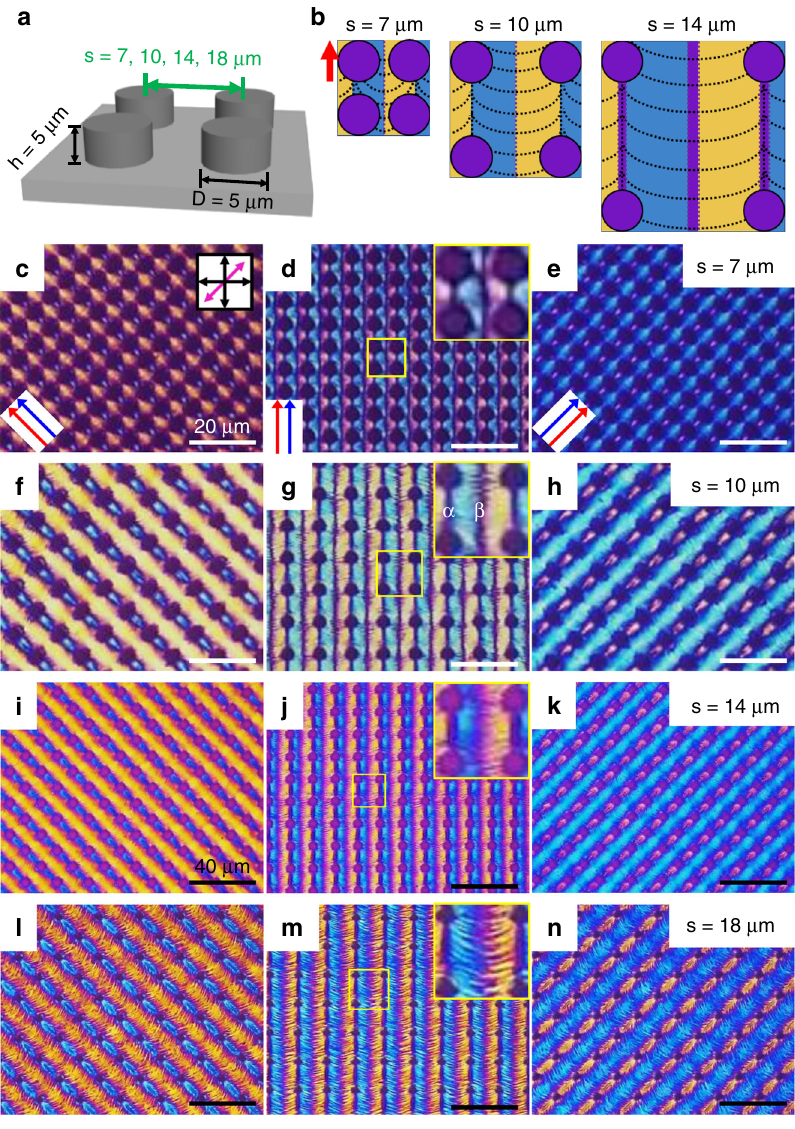
Fig. 4 Variation in DNA microstructures depending on separation between microposts. a The micropost-patterned substrate and its dimensions. b Schematic sketch of the aligned DNA chains for each condition. c – n POM images of DNA microstructures for varying s , and by rotating samples ± 45°. White scale bars represent 20 μ m and black ones are 40 μ